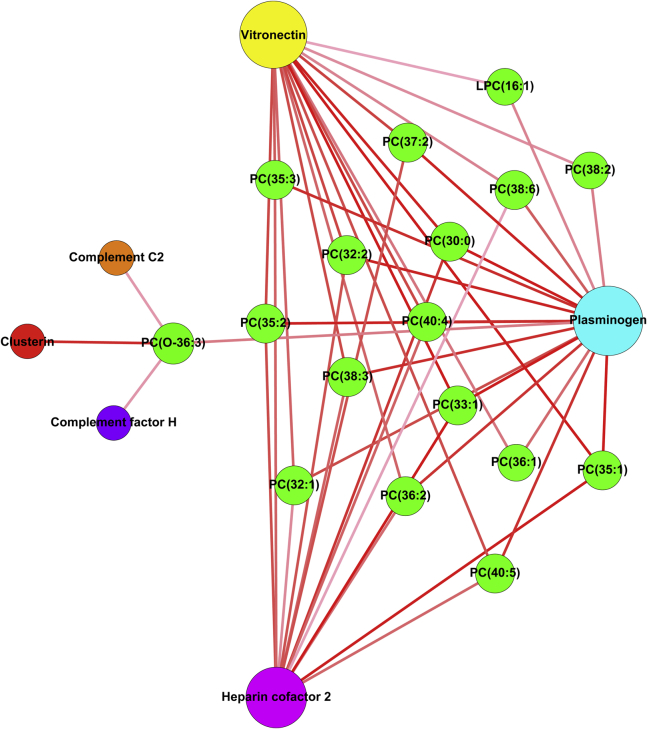
Relevance network graph depicting correlations derived from regularized canonical correlation analysis between lipids and proteins based on a similarity score >.3 (45). Nodes (circles) represent variables and are sized according to number of connections. Lines are colored according to association score with augmented intensity indicating higher correlation scores. LPC, lysophosphatidylcholine; PC, phosphatidylcholine.